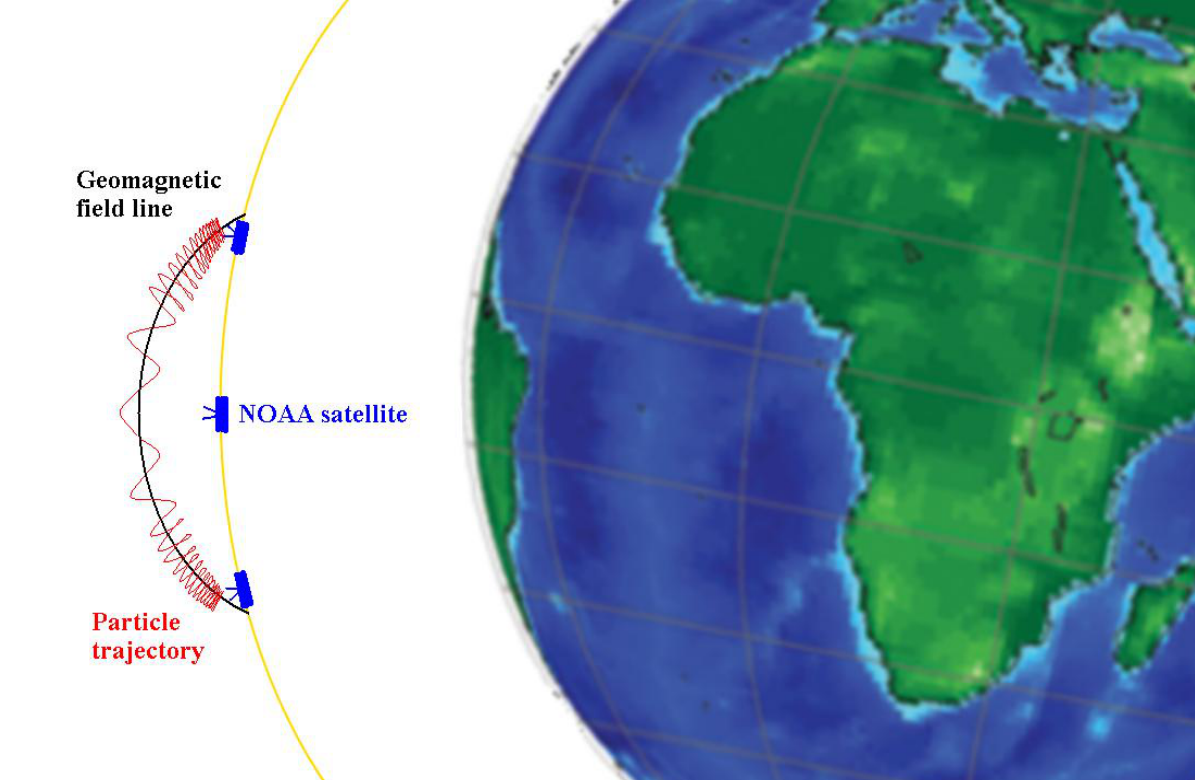
Figure 6. In the region just west of the SAA, the satellite orbit (yellow) crosses the mirror points of the geomagnetic line (black) of the internal VAB. In this region, the particle trajectories (red) can be detected by the 0° detector which has an aperture of 30°. At different longitudes the orbit crosses the same shell at different